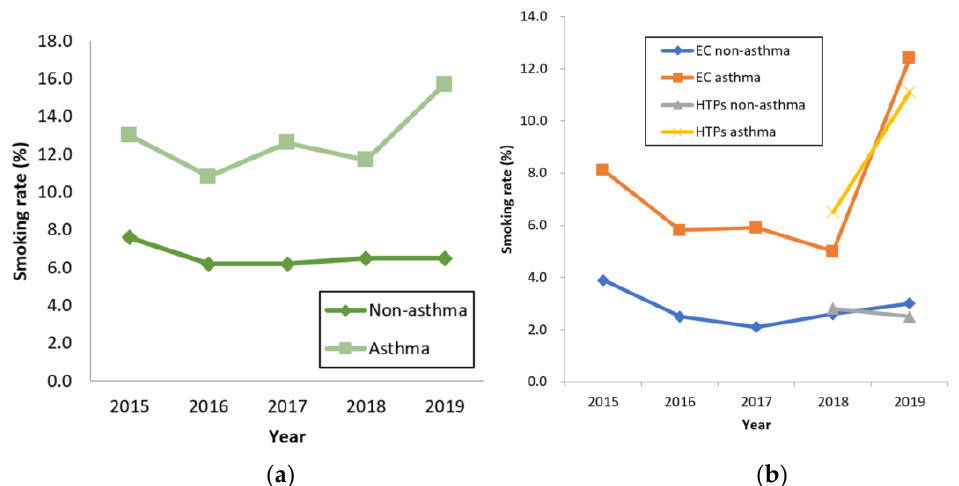
Figure 1. Rate of cigarette use by asthma status: ( a ) rates of combustible cigarette use by asthma status; ( b ) rates of e-cigarette and heated tobacco product use by asthma status.